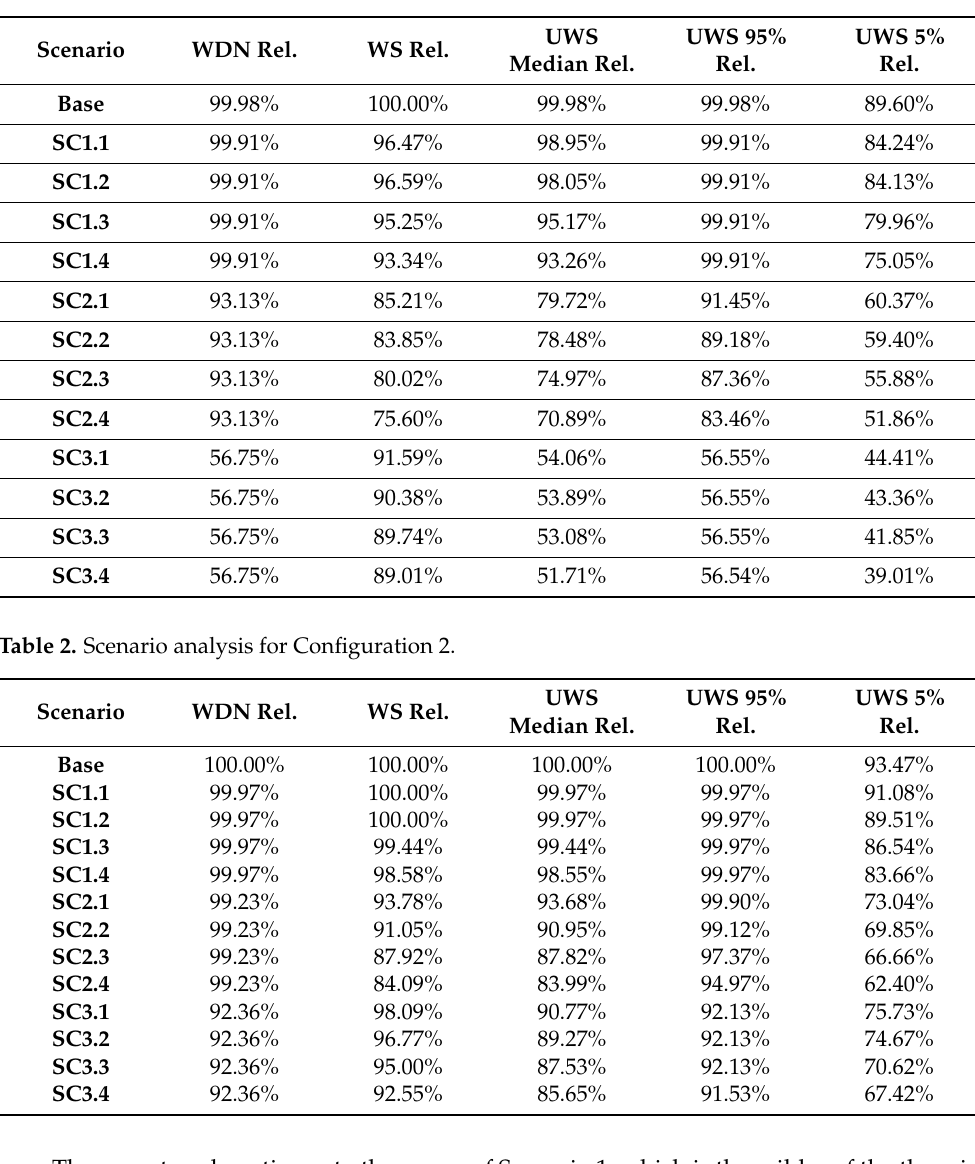
Table 1. Scenario analysis for Configuration 1.